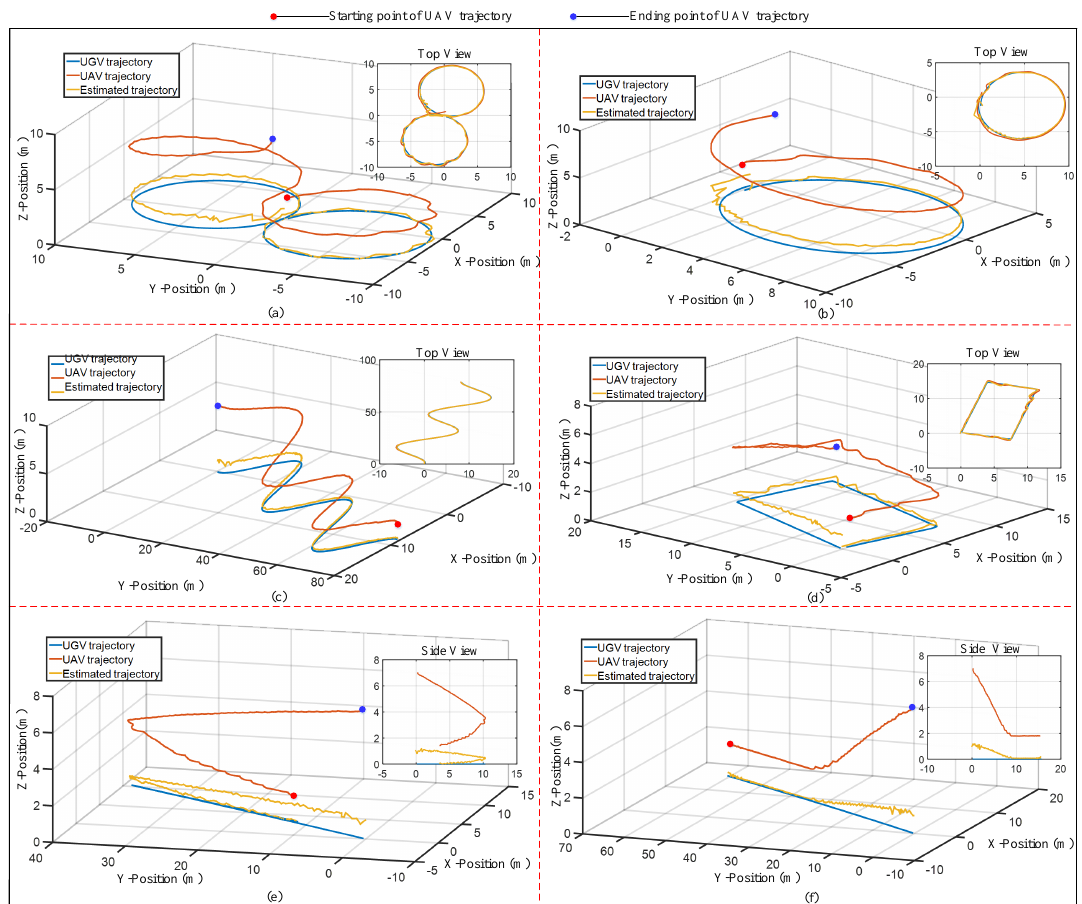
Figure 9. The experimental results of several kinds of 3D trajectories, such as figure-of-eight, circle, S-shape, rectangle, straight line, etc. ( a – c ) The movement direction of the UGV is constantly changing in both the X and Y directions; ( d , e ) The movement direction of the UGV is changing in the X or Y direction; ( f ) Maintaining forward